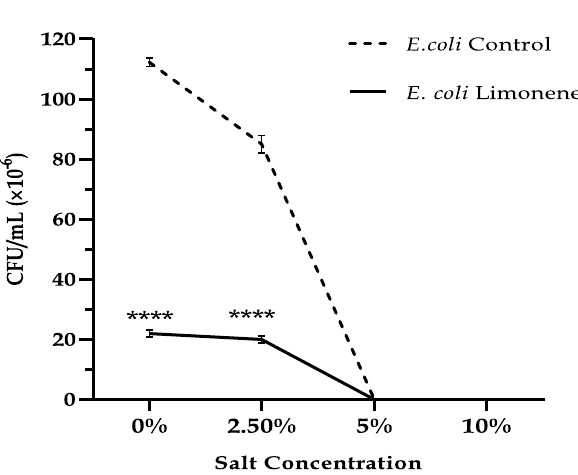
Figure 2. Salt tolerance of Escherichia coli treated with limonene